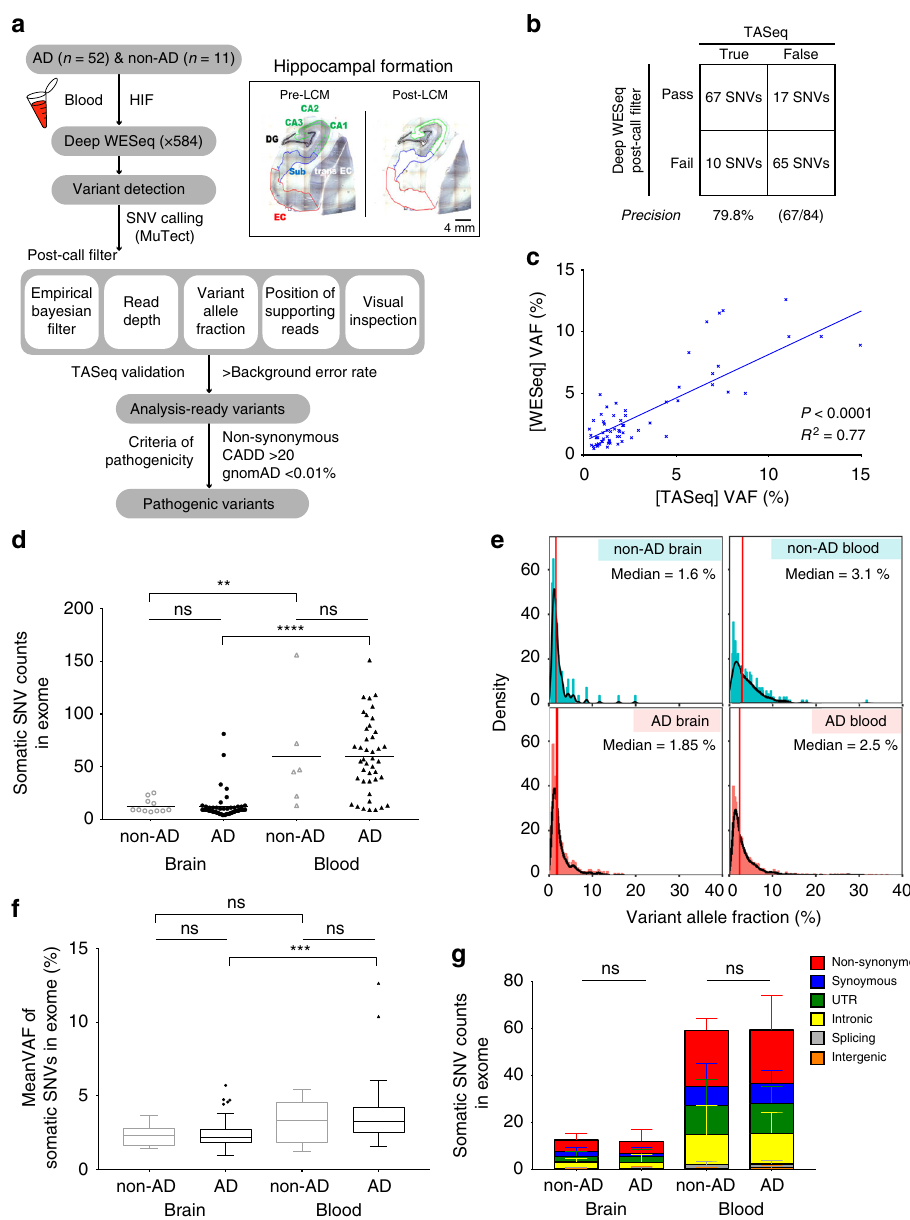
Fig. 1 Bioinformatic analysis pipeline and quantitative comparison of somatic single-nucleotide variations (SNVs) found in hippocampal formation (HIF) and blood tissues from Alzheimer ’ s disease (AD) and non-AD individuals. a Schematic fi gure for the bioinformatic analysis pipeline used in this study. b Validation results of post- fi ltered brain somatic mutations using targeted amplicon sequencing. Post- fi lter criteria ensured a precision of 79.8% in detecting fi ltered somatic SNVs. c Correlation of variant allelic frequency (VAFs) for 67 true calls between deep whole-exome sequencing and targeted amplicon sequencing. d Comparison of average mutation counts of somatic SNVs in HIF and blood tissues from AD and non-AD individuals. e Distribution of VAFs of pooled SNVs in each tissue from AD and non-AD individuals. Median VAF is indicated in red bars on each panel. f Comparison of mean VAFs in each group, which are shown as box plots (center line, median; box limits, upper and lower quartiles; whiskers, maximum and minimum values; points, outliers). g Contribution of six different mutation subtypes found in each group and data are mean ± SD. P values were calculated by one-way analysis of variance (ANOVA) test, followed by post hoc multiple comparison in d , f . P values were calculated by two-way ANOVA test, followed by post hoc multiple comparison in g . ns, not signi fi cant; ** p < 0.01; *** p < 0.001; **** p < 0.0001. Source data is available as a Source Data fi le